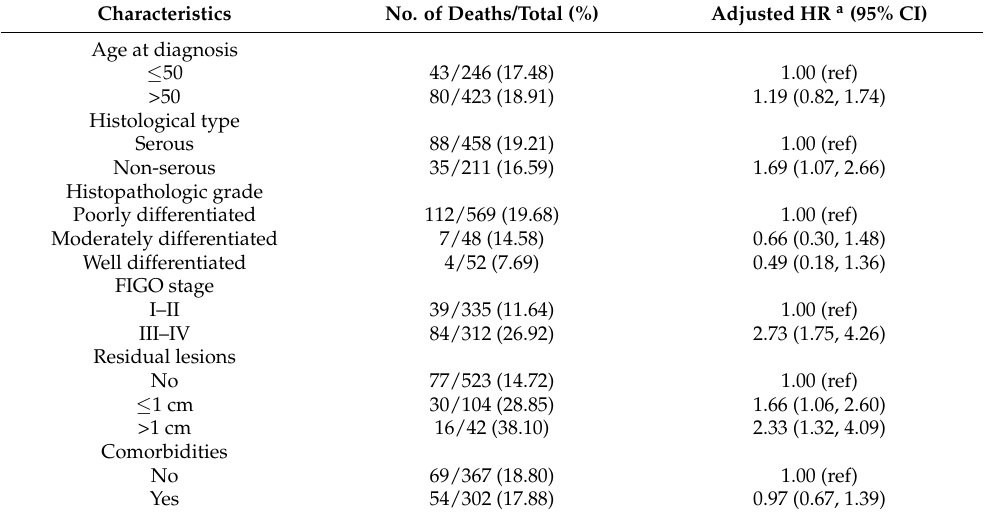
Table 2. Associations between clinical characteristics and all-cause mortality among women diag- nosed with ovarian